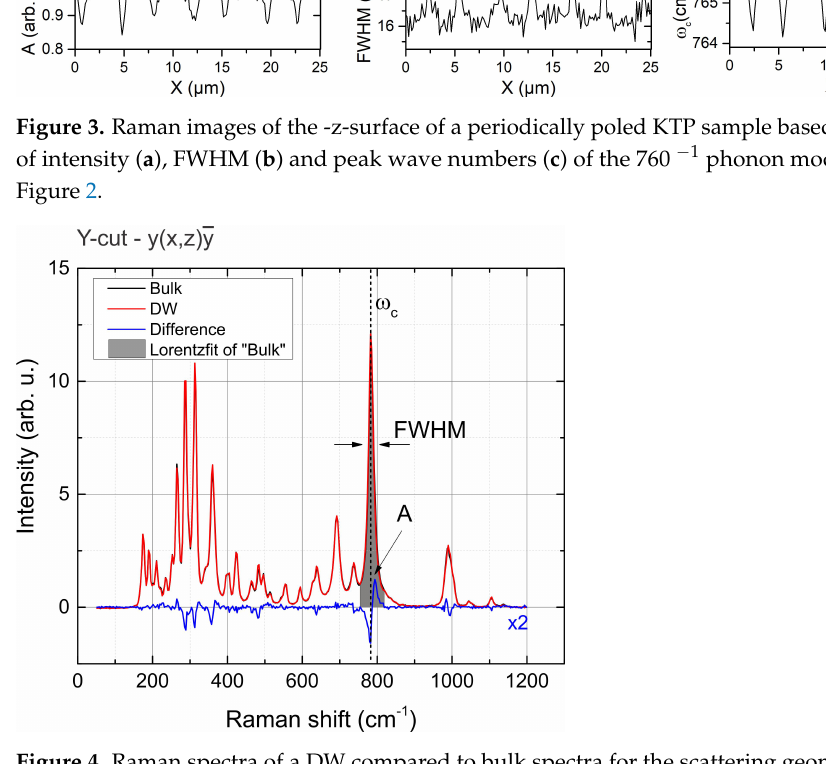
Figure 4. Raman spectra of a DW compared to bulk spectra for the scattering geometry y(x,z)y. For better visibility of the changes a difference spectrum is